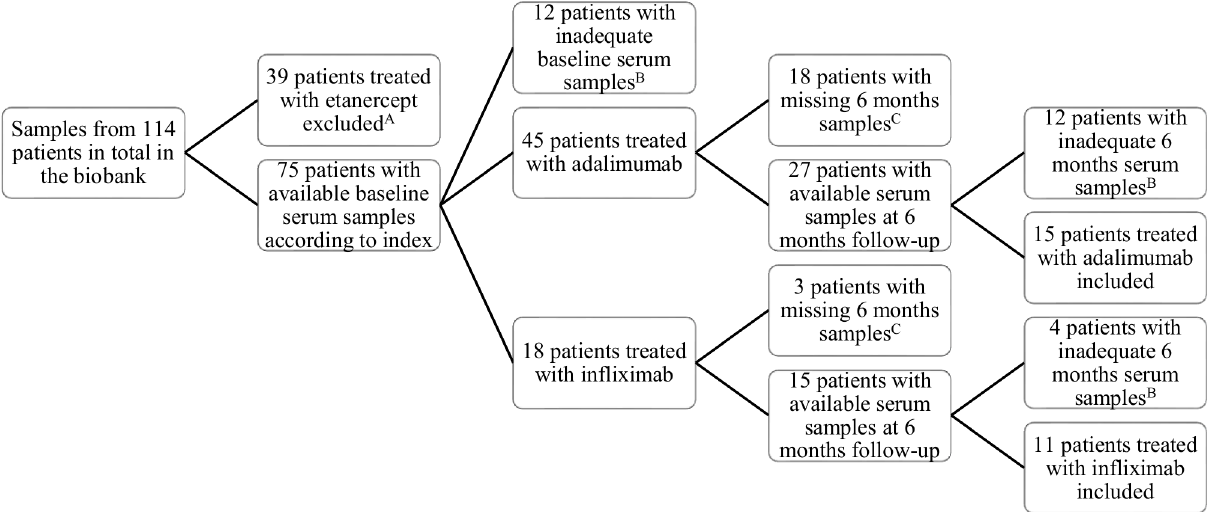
Fig 1. Flow diagram of the selection of patients in this study. Patients were recruited among all patients diagnosed with rheumatoid arthritis and treated with a TNFi, with serum samples available at the research biobank at the Parker Institute, Copenhagen University Hospital at Frederiksberg and Bispebjerg, Denmark. A Only patients treated with adalimumab or infliximab were included, as we did not have access to a reliable detection method regarding antibodies towards etanercept. B Vials were adequate only if they had not been previously thawed. At baseline, one vial of (cid:1) 3 μ l was required, and at 6 months follow-up 2 vials of (cid:1) 3 μ l were required. C Missing samples due to inclusion in project not requiring 6 months sampling, termination of current treatment, or lost to